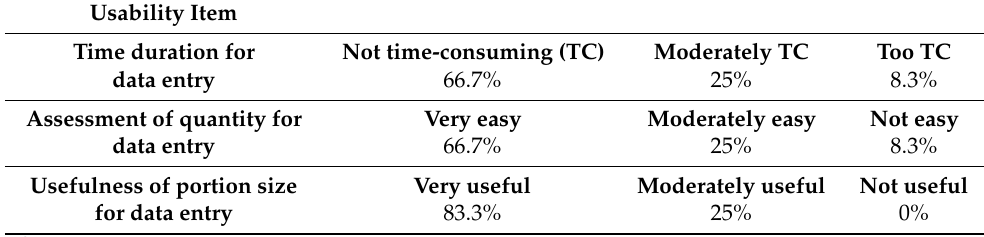
Table 6. Nutricate© users’ satisfaction response.